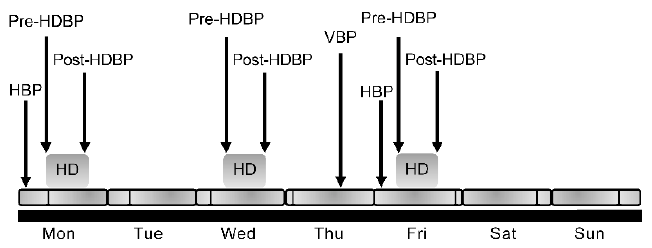
Figure 1. Blood pressure measurements over a one-week period. HBP, home blood pressure; VBP, visit blood pressure; HD; hemodialysis; HDBP, hemodialysis blood pressure.